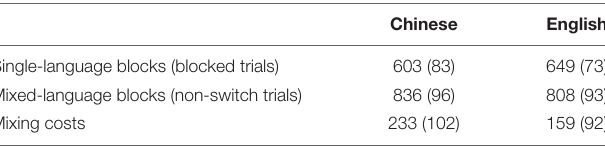
TABLE 4 | Mean RTs in ms (SD) in concept non-switch and switch trials and switch costs presented separately for Chinese and English.